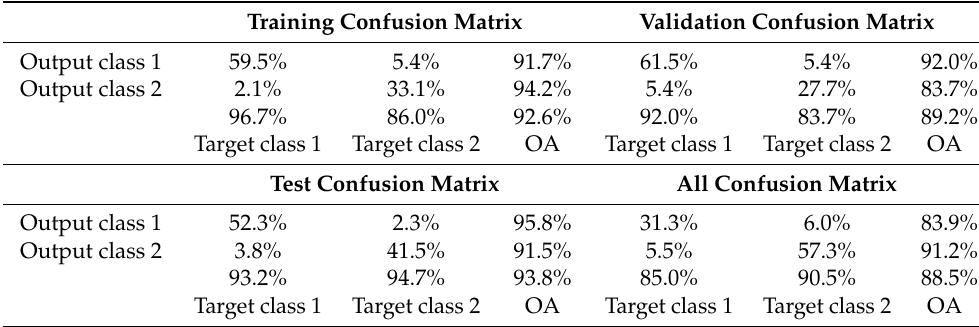
Table 4. Confusion matrix result from the application of the NN classification procedure with the new dataset.